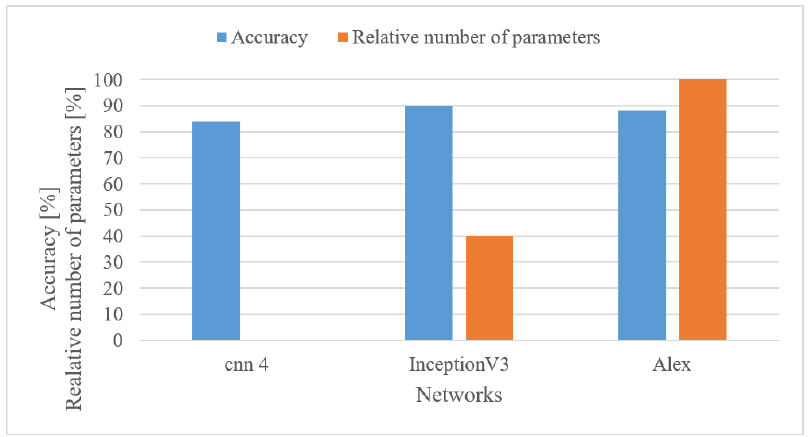
Figure 22. Accuracies and relative numbers of trainable parameters for a custom 4-layer CNN (CNN 4), Inception V3, and Alexnet networks and 0–4 kHz log spectrograms.